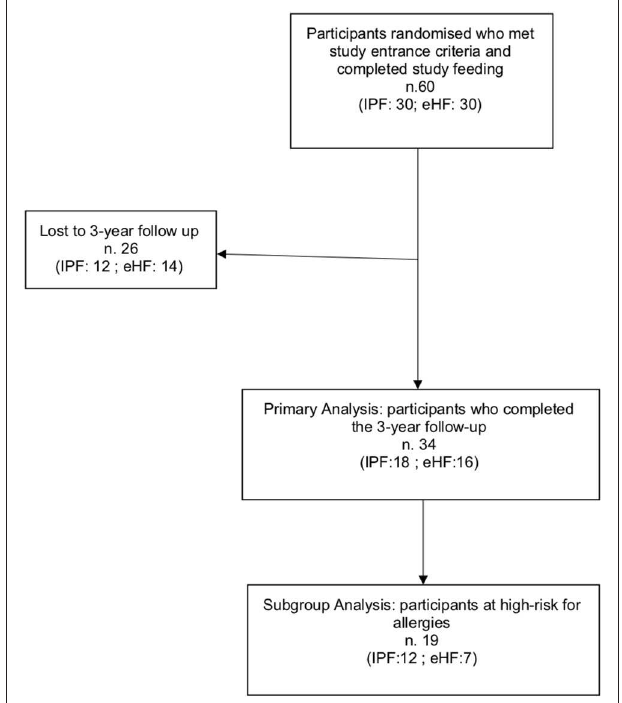
FIGURE 1 | Flow chart of the study recruitment